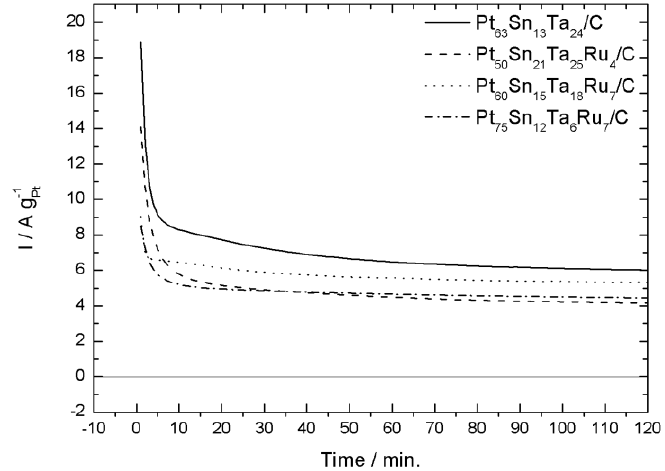
Figure 5. Chronoamperometry in ethanol 1.0 mol L −1 in H 2 SO 4 0.5 mol L −1 with a potential of 0.4 V vs. Ag/AgCl for 2 h.